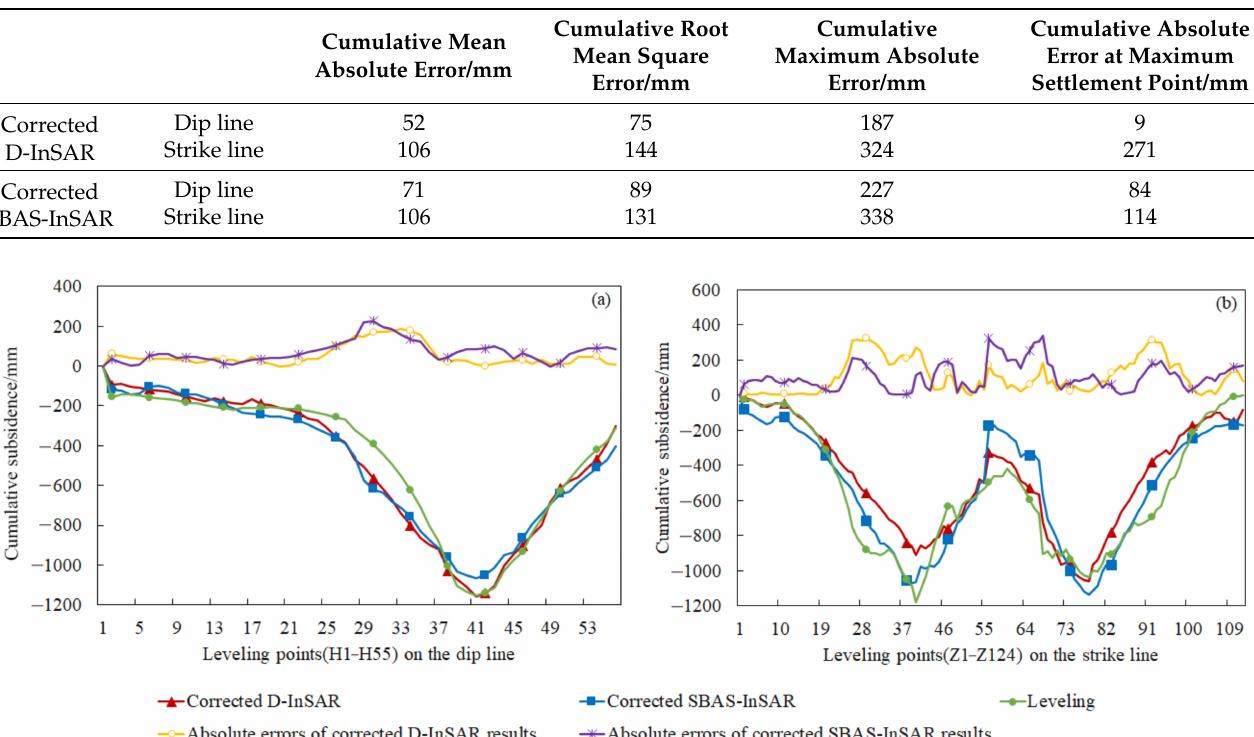
Figure 12. The comparison between the corrected InSAR- and leveling-monitored results: ( a ) dip line and ( b ) strike